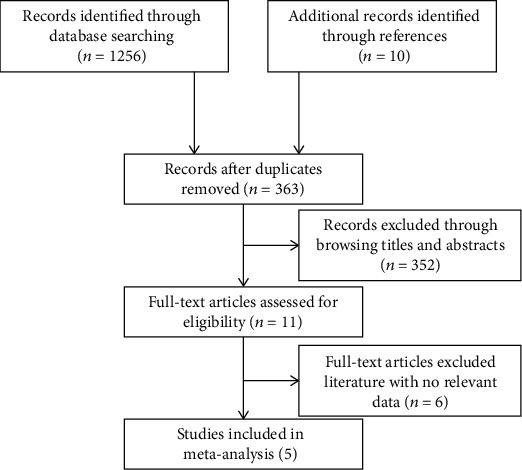
Flow diagram of the entire research literature.